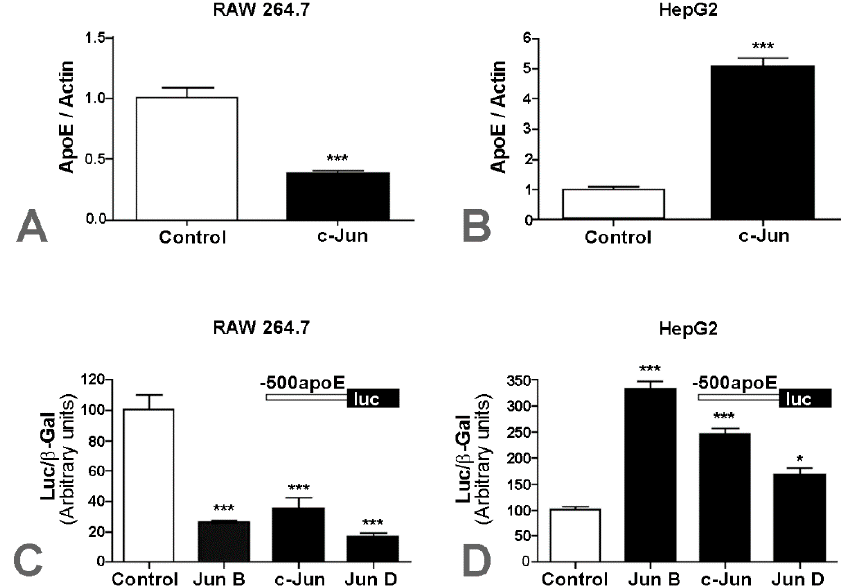
Figure 1. Cell-specific effects of c-Jun on apolipoprotein E (apoE) gene expression in macrophages and hepatocytes. RAW 264.7 ( A ) and HepG2 ( B ) cells were transfected with c-Jun-encoding plasmids, and apoE gene expression was determined by real-time PCR. Overexpression of c-Jun in RAW 264.7 cells caused a reduction in apoE mRNA level down to ~40% of the basal apoE level ( p < 0.01). By contrast, c-Jun overexpression in HepG2 cells induced a ~5-fold increase in apoE mRNA levels ( p < 0.001), compared to control cells; RAW 264.7 ( C ) and HepG2 ( D ) cells were transiently transfected with the construct − 500apoE in the absence (control) or in the presence of JunB, c-Jun, or JunD expression vectors. In RAW 264.7, cell JunB overexpression reduced apoE promoter activity to ~25% of the control value, c-Jun caused a reduction of activity to ~30% of the control, and JunD reduced its activity to ~20% of the control ( p < 0.001 for each case). By contrast, the overexpression of JunB in HepG2 cells increased apoE promoter activity ( p < 0.001) ~3.4-fold, c-Jun increased its activity ( p < 0.01) ~2.6-fold, and JunD increased apoE promoter activity ( p < 0.05) 1.6-fold.